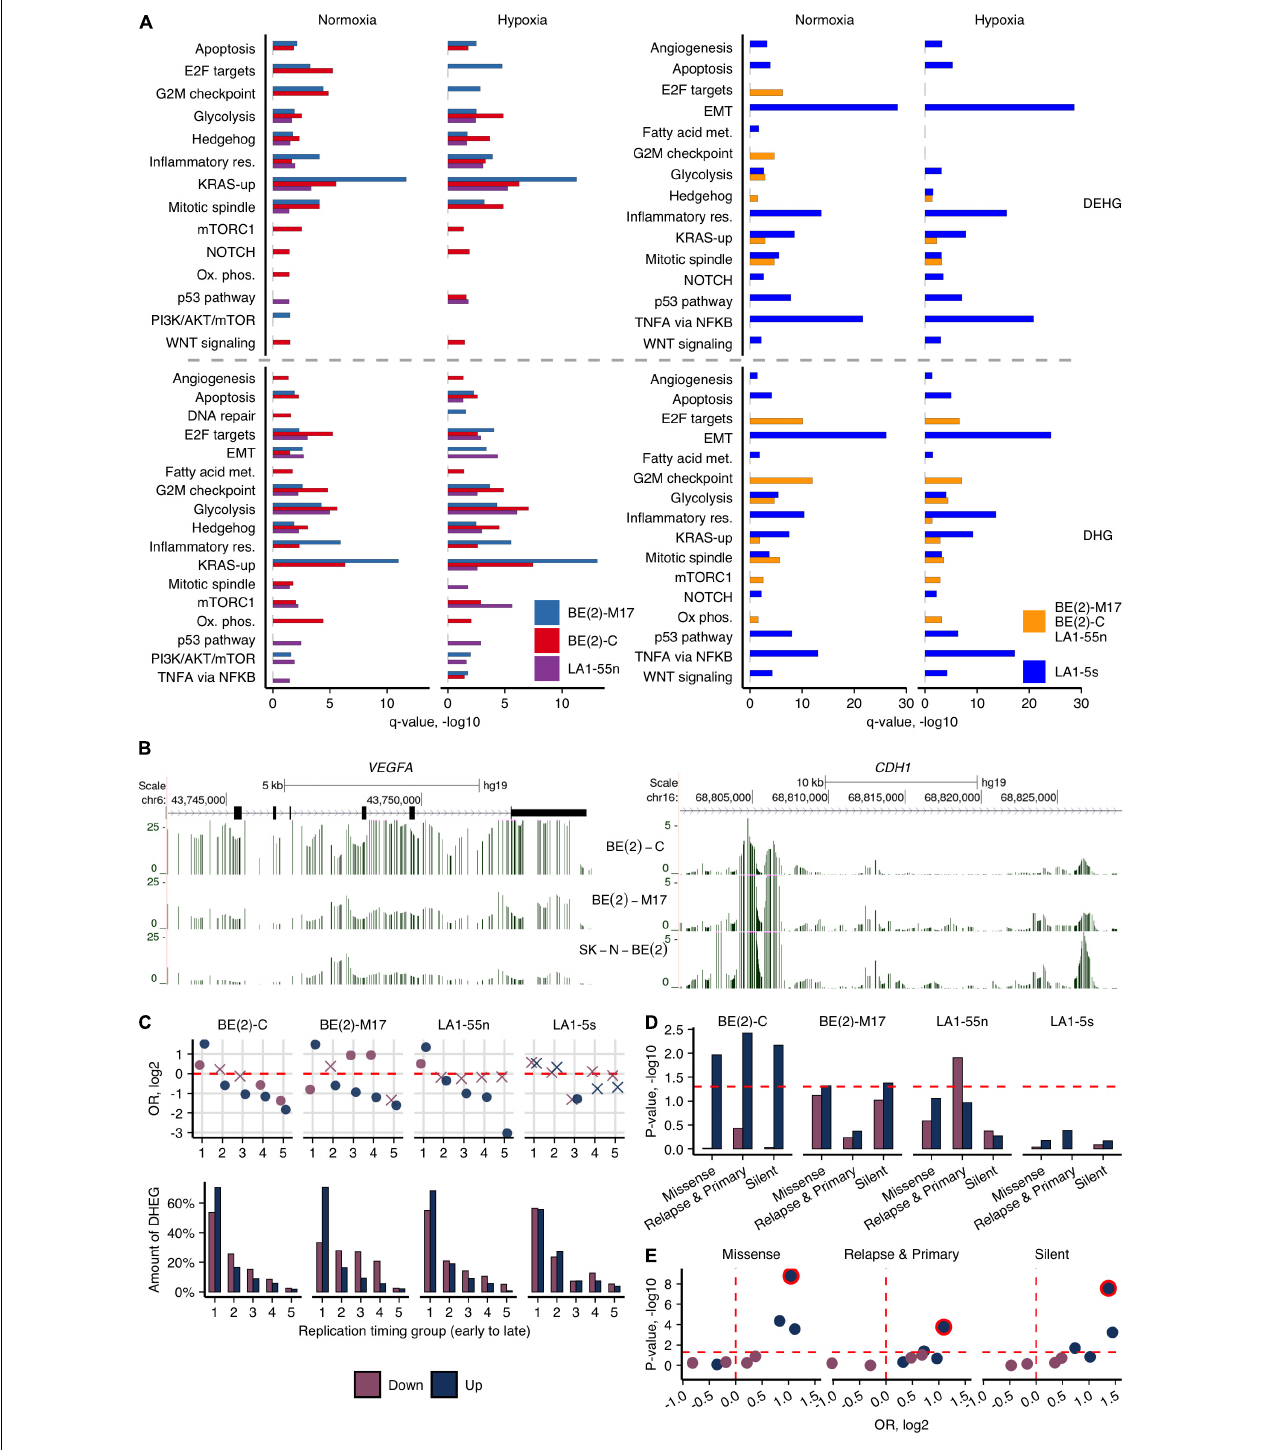
FIGURE 3 | Cell type-specific 5hmCG differences of NB cells. (A) Molecular pathway enrichment analysis of DEHGs and DHGs identified by comparing each of the ADRN cells [BE(2)-C, BE(2)-M17, and LA1-55n] against the MES/NCC-like LA1-5s cells or between LA1-5s and all three ADRN cells combined, in normoxia and hypoxia. Significance of pathway enrichment is represented by q -value. Met., metabolism; Res., response. (B) Browser representation of h-density profiles across the loci of CDH1 and VEGFA genes in hypoxic cells of the SK-N-BE(2) group shows the decreased and increased signal in BE(2)-C, respectively. (C) OR from Fisher’s exact test and fractions of Up- and Down-DEHGs across genomic regions, which were assigned numbers from 1 to 5 based on replication timing (1